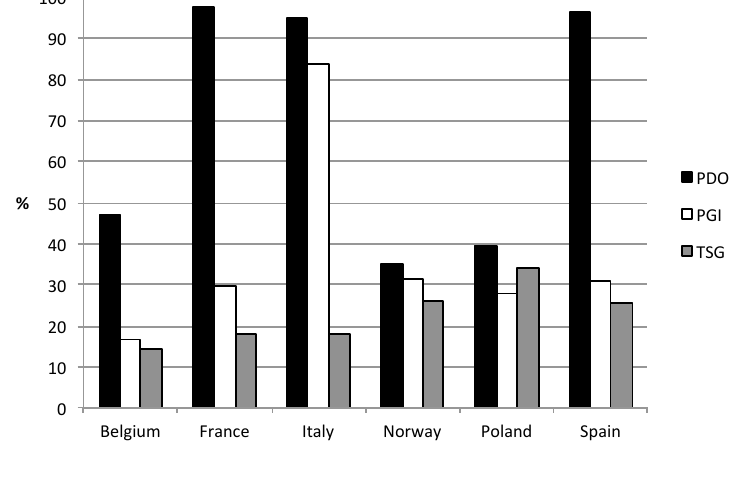
Figure 2. Consumers’ awareness of Protected Designation of Origin (PDO), Protected Geographical Indication (PGI) and Traditional Speciality Guaranteed (TSG) in Belgium, France, Italy, Norway, Poland and Spain; total n = 4,828; n = 800 per country